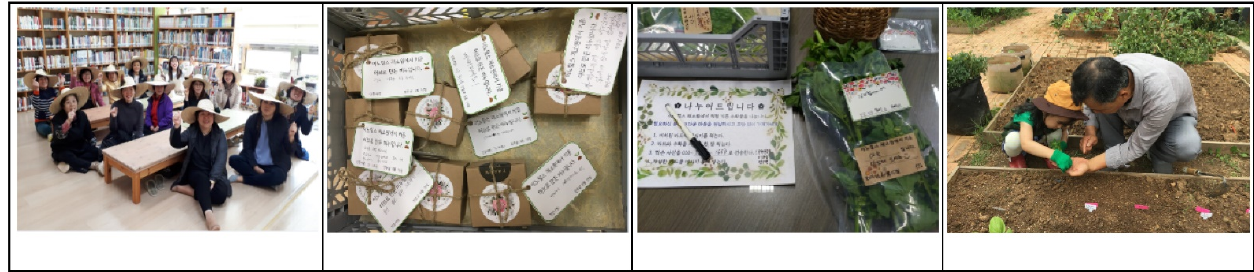
Figure 3. Snapshots showing the process of the SCG program. SCG: group participating in the apartment community garden program based on the sense of community theory. Table 4. The SCG program.